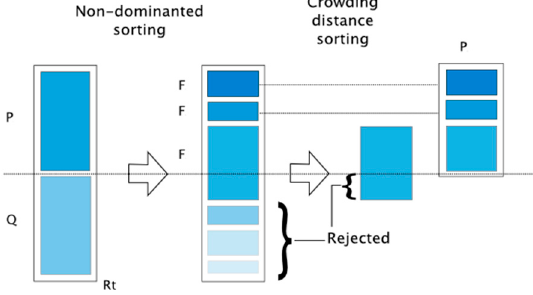
Figure 1. NSGA-II procedure.